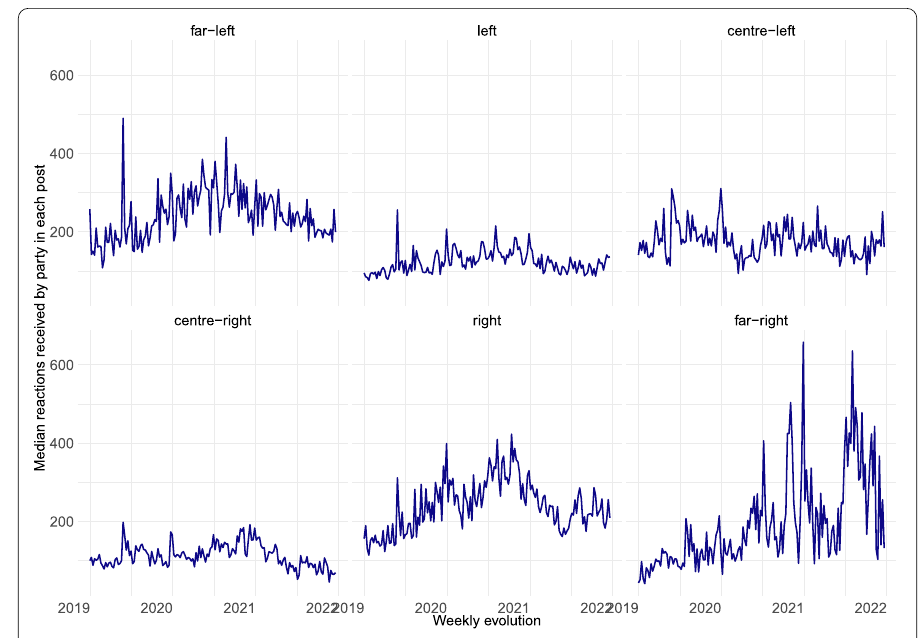
Figure 17 Median number of reactions received in each post by different ideology